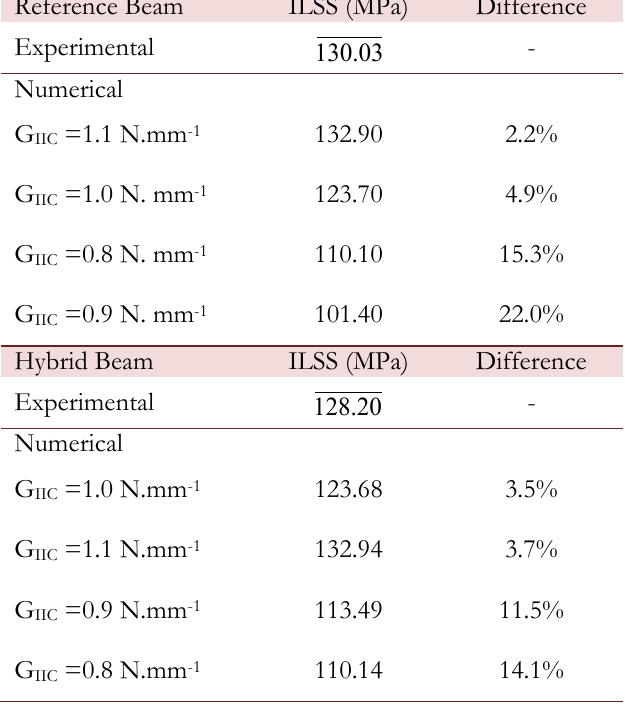
Table 4: Comparison between experimental average results and numerical results